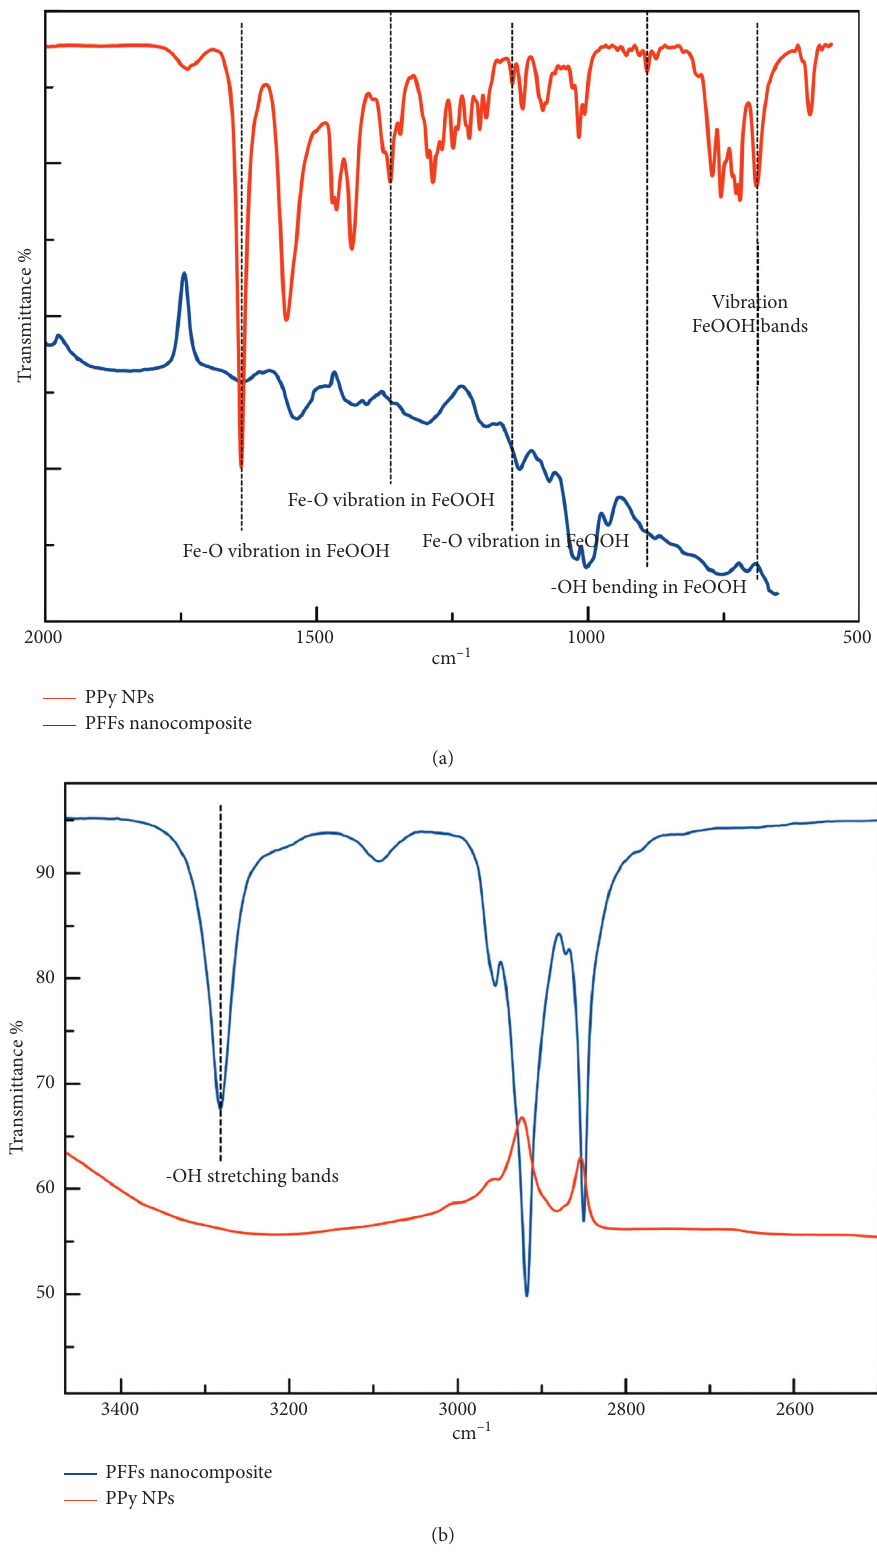
Figure 5: FTIR spectra of PPy NPs and PFFs nanocomposite at 2000–3500 cm − 1 (a) and at 500–2000cm − 1